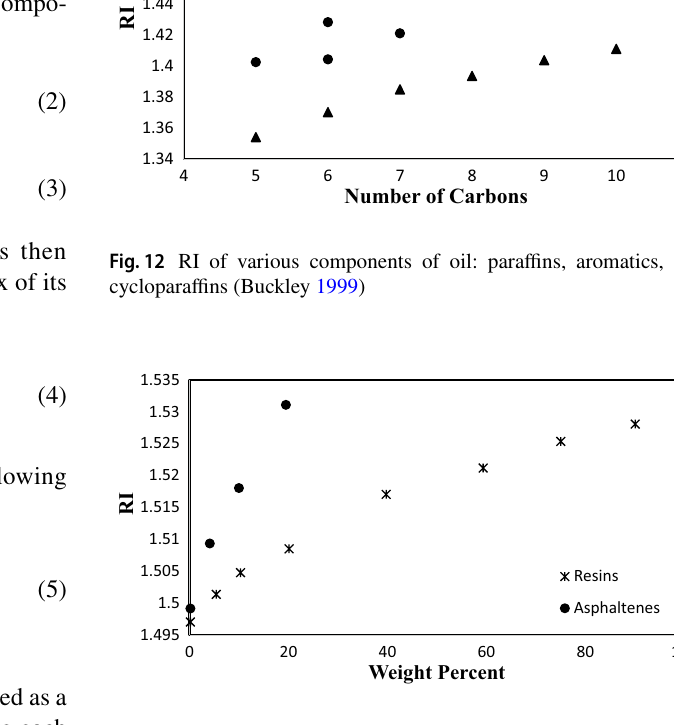
Fig. 13 RI of resins and asphaltenes (in toluene solutions) from